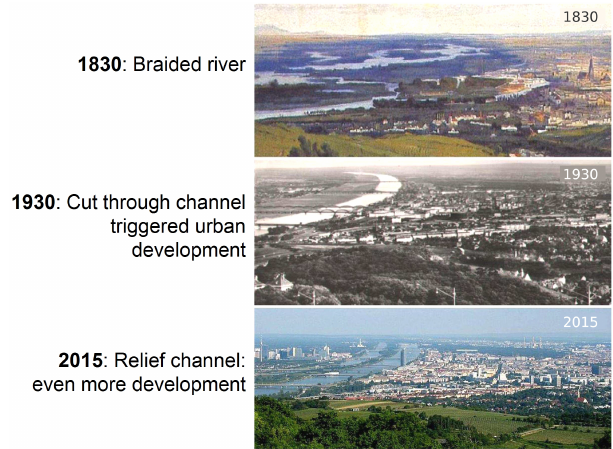
Figure 10. Long-term human–flood interactions illustrated for the Danube at Vienna, Austria. In 1830, the river near Vienna was braided. As a consequence of devastating floods, a cut-through channel was constructed in 1870, as seen in the photo of 1930. The enhanced protection triggered urban development on the flood plain, which required an additional relief channel constructed in 1970, which eventually led to further urban development. The at- tempt of increasing protection has thus increased rather than re- duced the damage potential. These unintended consequences are studied in socio-hydrology (Barendrecht et al.,